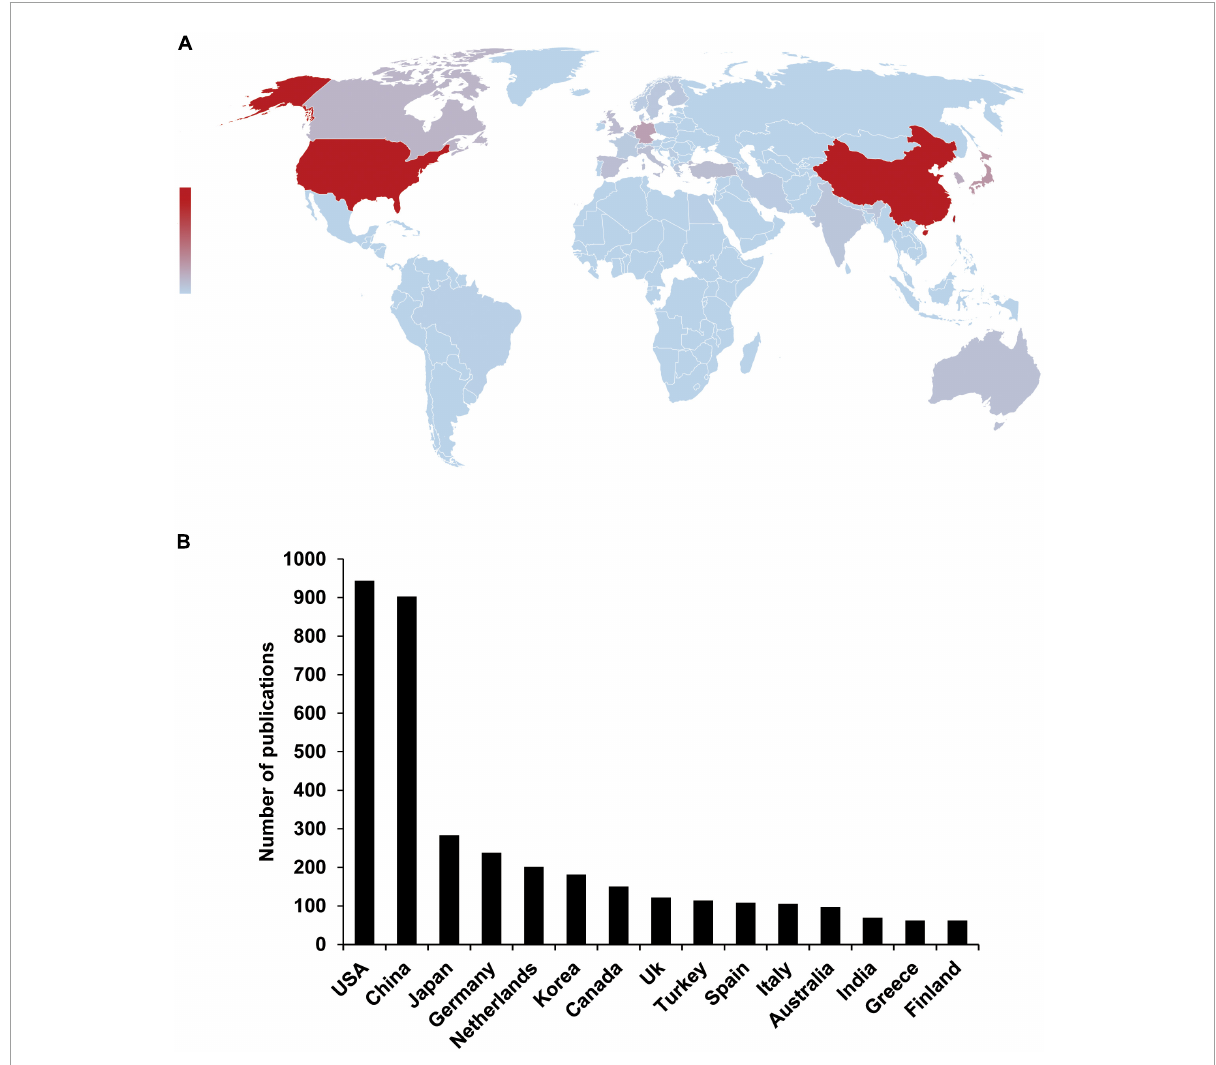
FIGURE3 Regional differences in the research status of global depression and radiology. (A) The map shows the global distribution of depression and radiology publications over 20 years. Country information was extracted based on publication affiliation. Countries or regions were drowned with publications; the darker the color, the greater the number of publications. The number of publications in the Northern Hemisphere is much higher than in the Southern Hemisphere. (B) Top 15 countries with the most published depression and radiology studies.